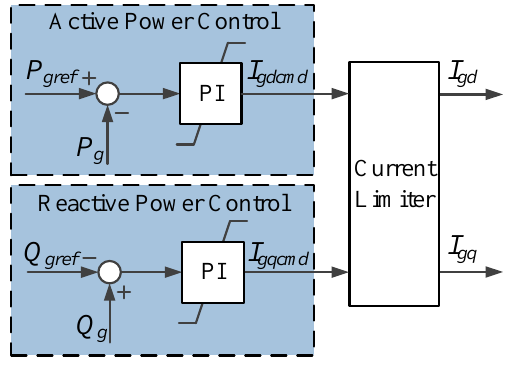
Figure 3. Control process of the PMSG controlled current source model.